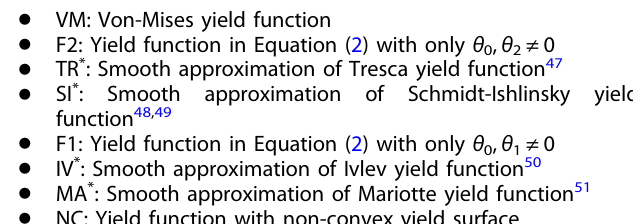
● TR * : Smooth approximation of Tresca yield function 47 ● SI * : Smooth approximation of Schmidt-Ishlinsky yield function 48,49 ● F1: Yield function in Equation (2) with only θ ● IV * : Smooth approximation of Ivlev yield function 50 ● MA * : Smooth approximation of Mariotte yield function 51 ● NC: Yield function with non-convex yield